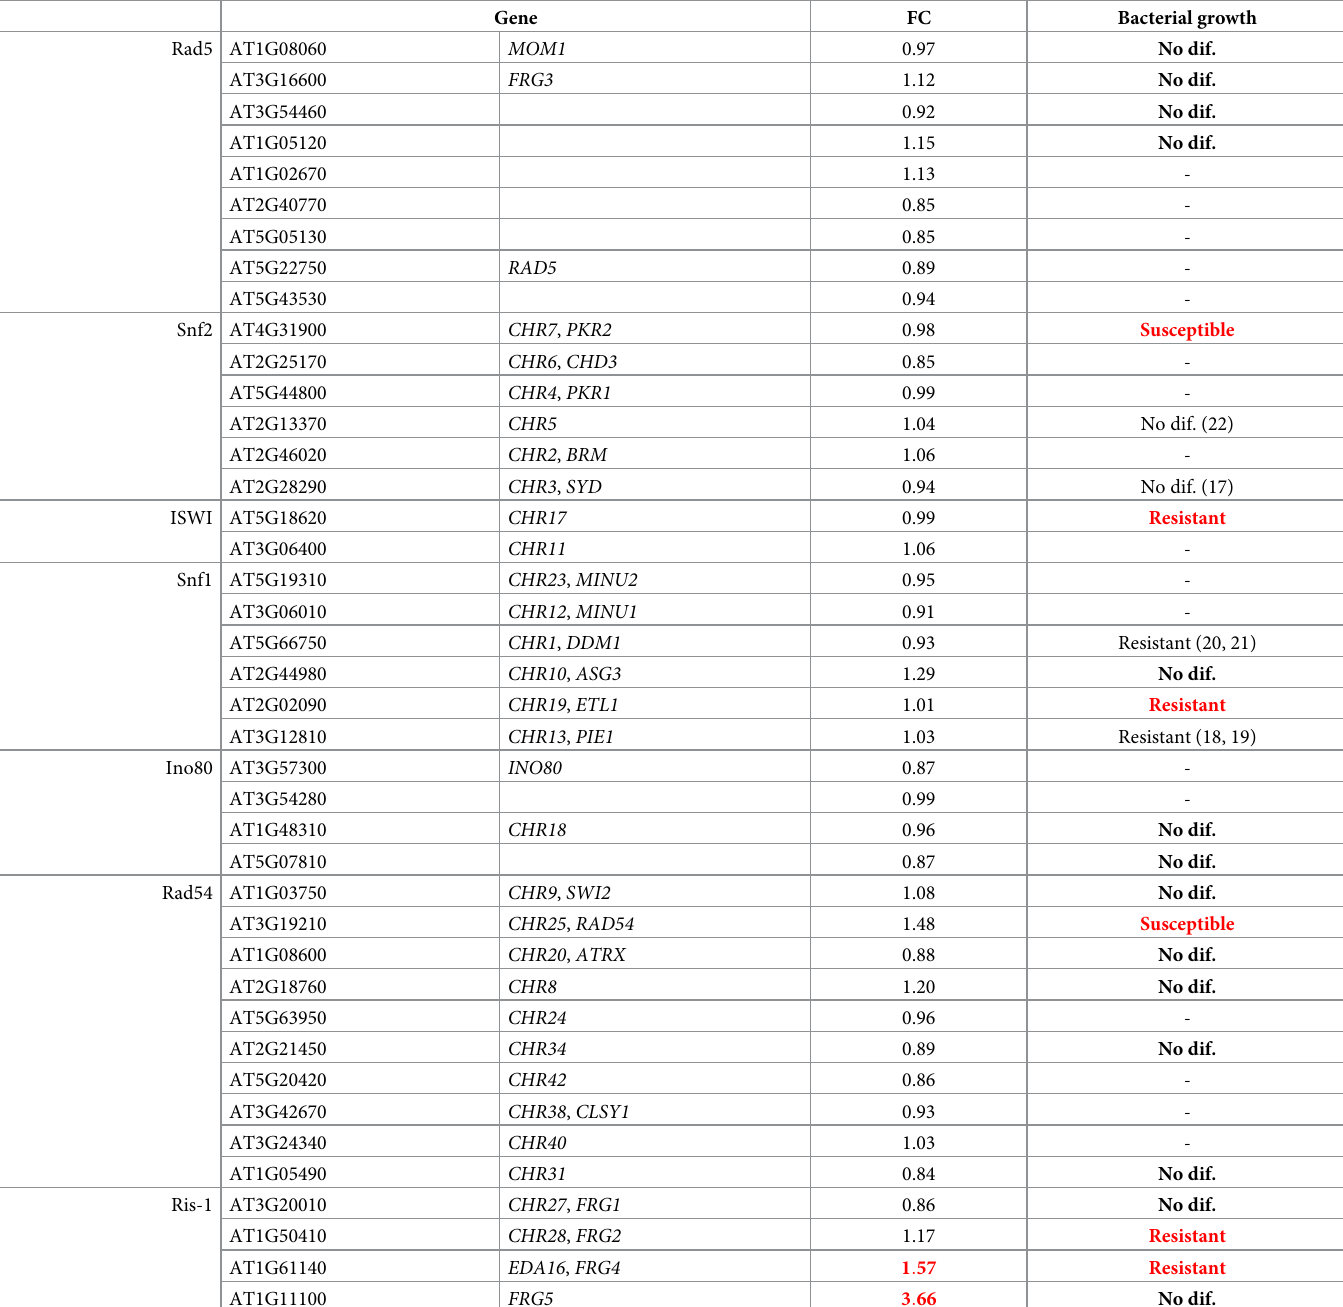
Table 1. Bacterial susceptibility screening of chromatin remodeling ATPase